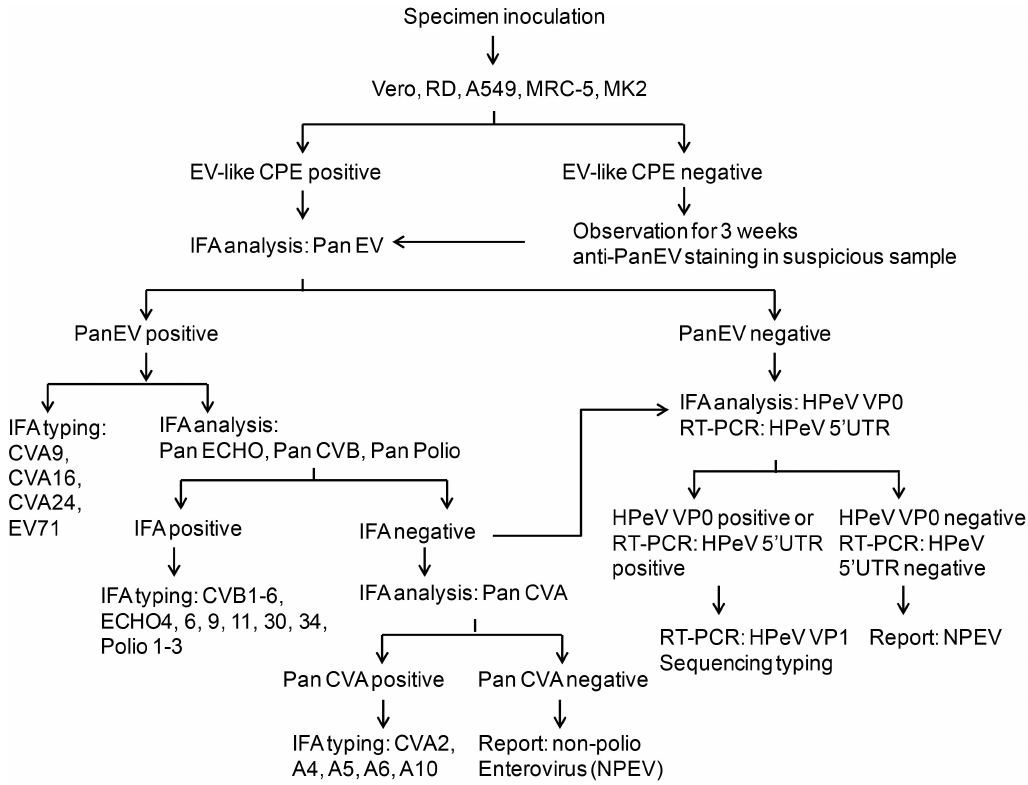
Figure 4. Schematic of HPeV diagnosis protocol. The schematic shows the process of HPeV diagnosis in a clinical virology laboratory. The procedures include specimen inoculation, cytopathic effect (CPE) evaluation, IFA staining and RT-PCR analysis of